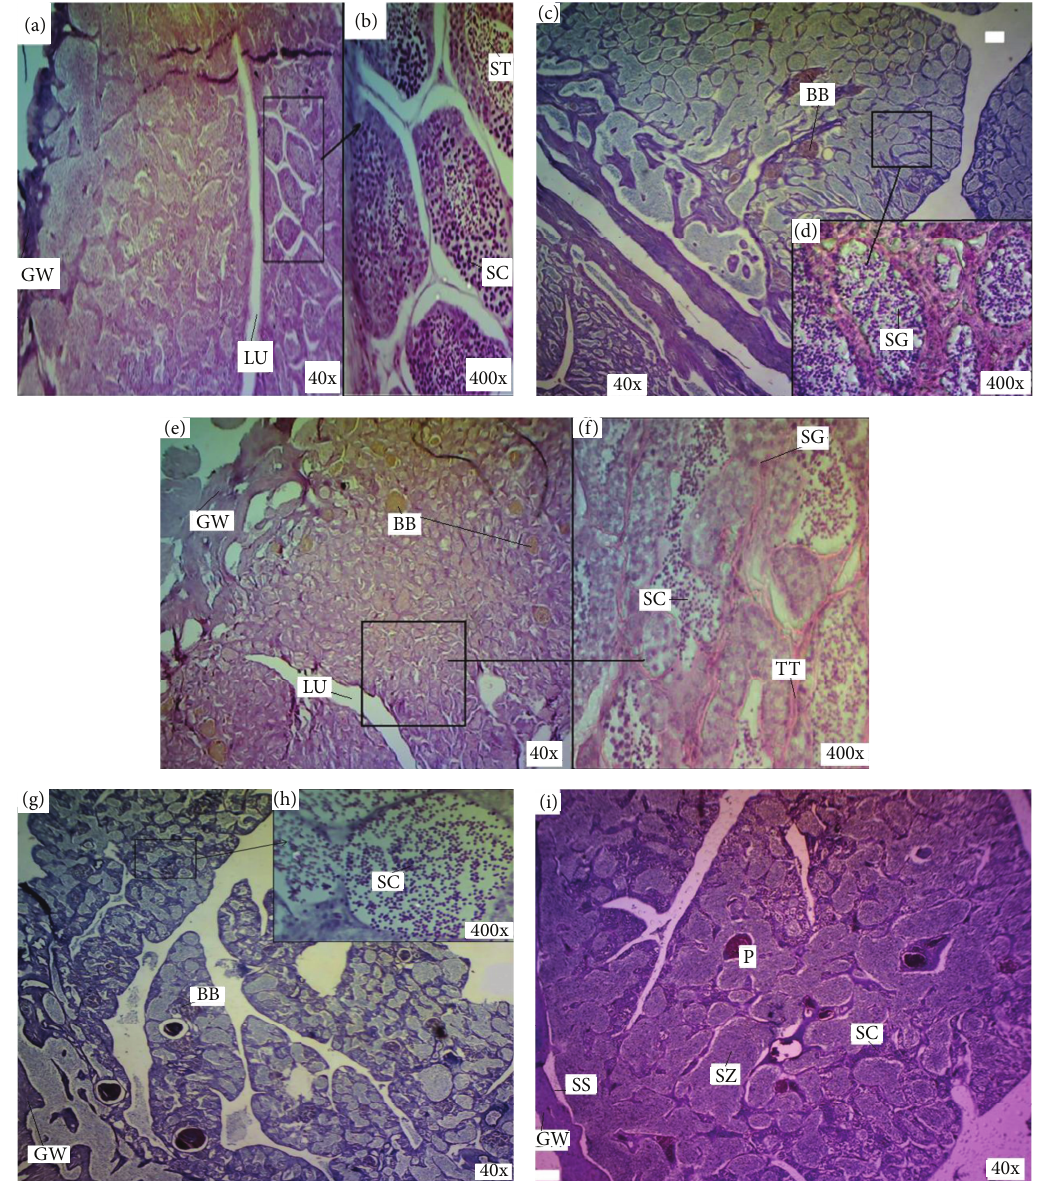
Figure 3: Histological sections of male Epinephelus malabaricus maturation stages of (a) mature ripening (M2) collected 1 February 2010, 97 cm 𝐿 𝑇 , 16kg 𝑊 𝑇 , 20.66 g 𝐺 𝑊 ; (c) resting male (M3) collected 20 February 2010, 109cm 𝐿 𝑇 , 23kg 𝑊 𝑇 , 39.11g 𝐺 𝑊 ; (e) resting male (M3) collected 28 February 2010, 100 cm 𝐿 𝑇 , 17kg 𝑊 𝑇 , 39.53 g 𝐺 𝑊 ; (g) mature ripening (M2) collected 23 January 2010, 105 cm 𝐿 𝑇 , 18kg 𝑊 𝑇 , 26.87 g 𝐺 𝑊 ; (i) mature ripe (M4) collected 9 September 2010, 103cm weight, 𝐿 𝑇 : total length, LU: lumen, SC: spermatocytes, SG: spermatogonia, SS: sperm sinus, ST: spermatid, SZ: spermatozoa, TT: testicular